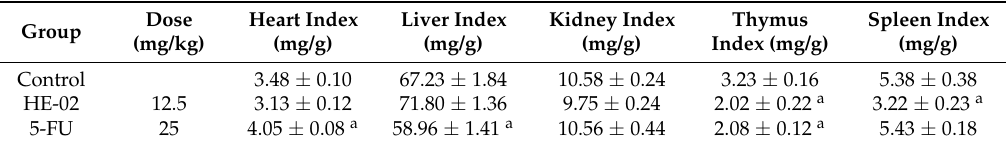
Table 5. Index of the organs of mice transplanted with Ehrlich ascites carcinoma after treatment with 5% tween 80 (control) solution, H-E02 (12.5 and 25 mg/kg) and 5-FU (25 mg/kg).